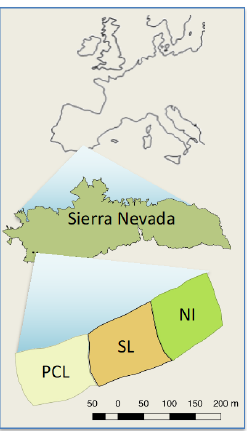
Figure 1. Location of the study site within Europe and the Sierra Nevada Protected Area. The three landscape units in which the weeding experiment was conducted were characterized by the post-fire intervention they received: NI = non-intervention unit; PCL = partial cut plus lopping unit; SL = salvage logging unit. The size of each unit was ca. 2 ha (see Table 1 for details). The burned trees in the NI and PCL landscape units fell during the course of the first post-fire years. The fallen fraction (measured in February each year) was 0.0% in 2006 and 2007, 13.3% in 2008, 84.6% in 2009, and 98.2% in 2010, with similar values in NI and PCL [36]. Accompanying post-fire vegetation was diverse and composed mainly of grasses and forbs, with a mean cover in spring 2007 of 84.0 ± 2.2% for NI, 62.2 ± 3.7% for PCL, and 64.0 ± 5.0% for SL (data for the units used in the present study, extracted from [9]). The most common species were grasses such as Dactilys glomerata L. and Festuca scariosa (Lag.) Ascherson & Graebner (Poaceae) and forbs such as Andryala integrifolia L., Carlina corymbosa L., Scorzonera angustifolia L. (Asteraceae), Thapsia villosa L. (Apiaceae), or Vaccaria hispanica (Miller) Rauschert (Caryophyllaceae) (see [9] for detailed list of species). 2.3. Effect of Herbaceous Cover on Pine Seedling Survival and Growth Within each landscape unit, we selected 100 naturally regenerating pine seedlings that were allocated one of two herb-interference treatments: unweeded (no action around pine seedling) or weeded (herbaceous cover removed in a diameter of 50 cm around the pine seedling with a weeding hoe, cutting all the vegetation except the seedling at ca. 5 cm below ground). All pine seedlings had at least 75% herbaceous cover (visual estimation) in a diameter of 1 m around them. The two treatments were intermingled following a stratified design; i.e., one weeded seedling was always followed by an unweeded seedling, and the distance among seedlings was at least 10 m. The seedlings were thus spread across the whole surface of the landscape units. The treatments were implemented in 2007 (second growing season; 2-year-old seedlings hereafter) and again on a different subset of seedlings in 2009 (4-year-old) to test the effect of herb cover at two age stages. Weeding was done in May, at the moment of maximum herbaceous growth in the area. The full experimental design therefore consists of three landscape units, within which each of two herbaceous-cover treatments was applied to 50 seedlings at each of two age classes (total: 600 seedlings; Figure 1). For each seedling, we measured stem height and stem basal diameter before the onset of the growing season (May 2007 and 2009), and survival, stem height, and stem basal diameter at the end